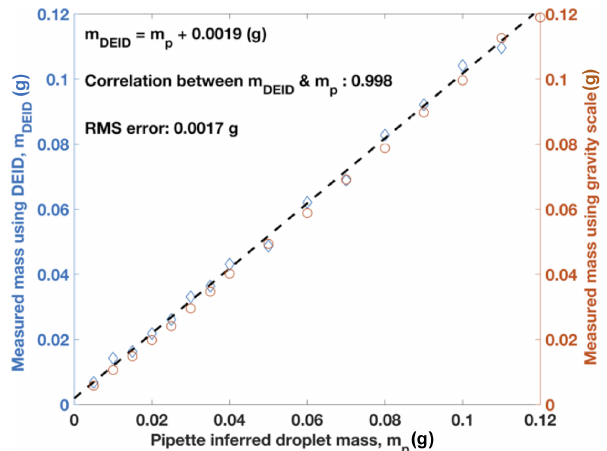
Figure 6. Correlation between the water-droplet mass measured from a pipette and that obtained using the DEID with the corre- sponding linear fit (coefficient of determination is 0.99). The mass of the water droplet was also measured using a weighing scale af- ter applying the water droplet on the scale through the pipette in a similar